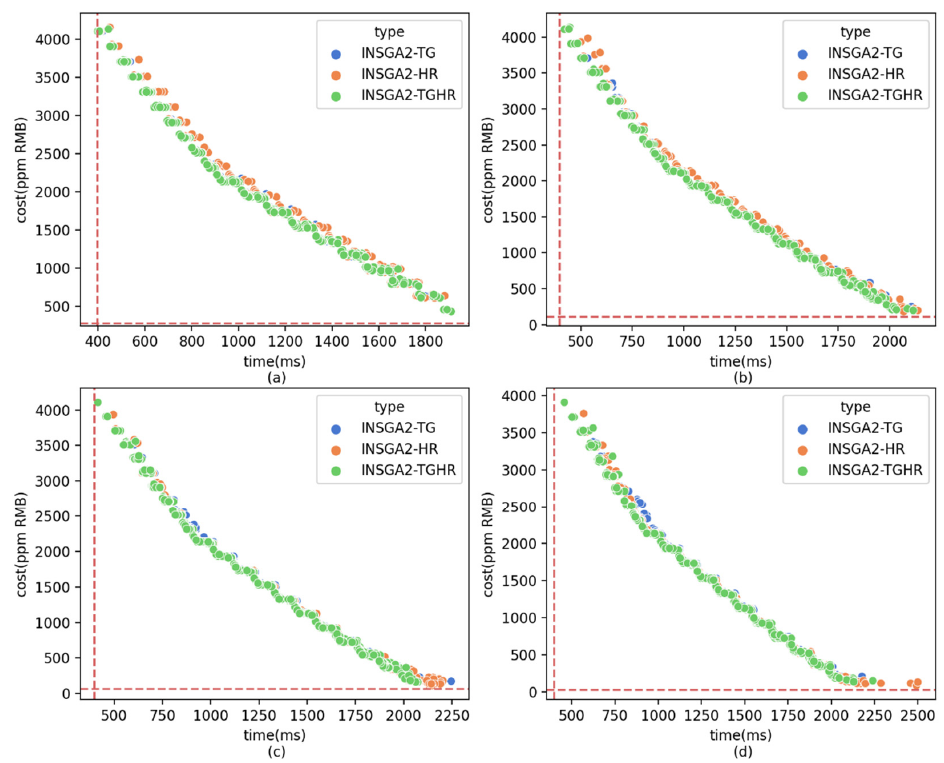
Figure 9. The Pareto frontier in different local resources setting. ( a ), ( b ), ( c ), ( d ) are comparing different resources in (4, 2, 1), (6, 2, 1), (8, 2, 1), (10, 2, 1) settings, respectively. (6, 2, 1), (8, 2, 1), (10, 2, 1) settings, respectively.